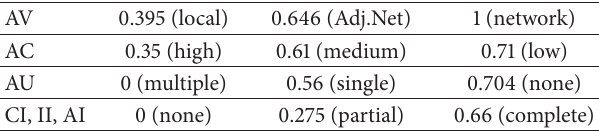
Table 1: Possible values of CVSS base metrics.